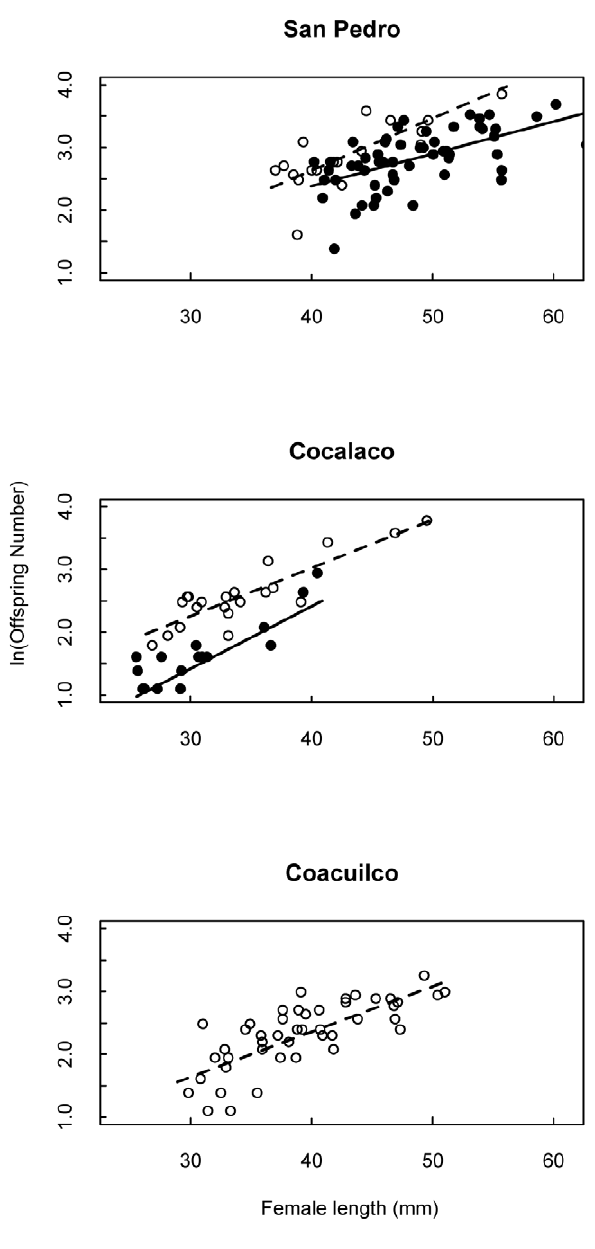
Figure 4. Female size and offspring number are positively correlated for all sites and years; Solid points are data from 2008; open circles are 2010. Offspring number was log-transformed, as fecundity is expected to increase geometrically with female size. In all cases, slopes are significantly different from zero.